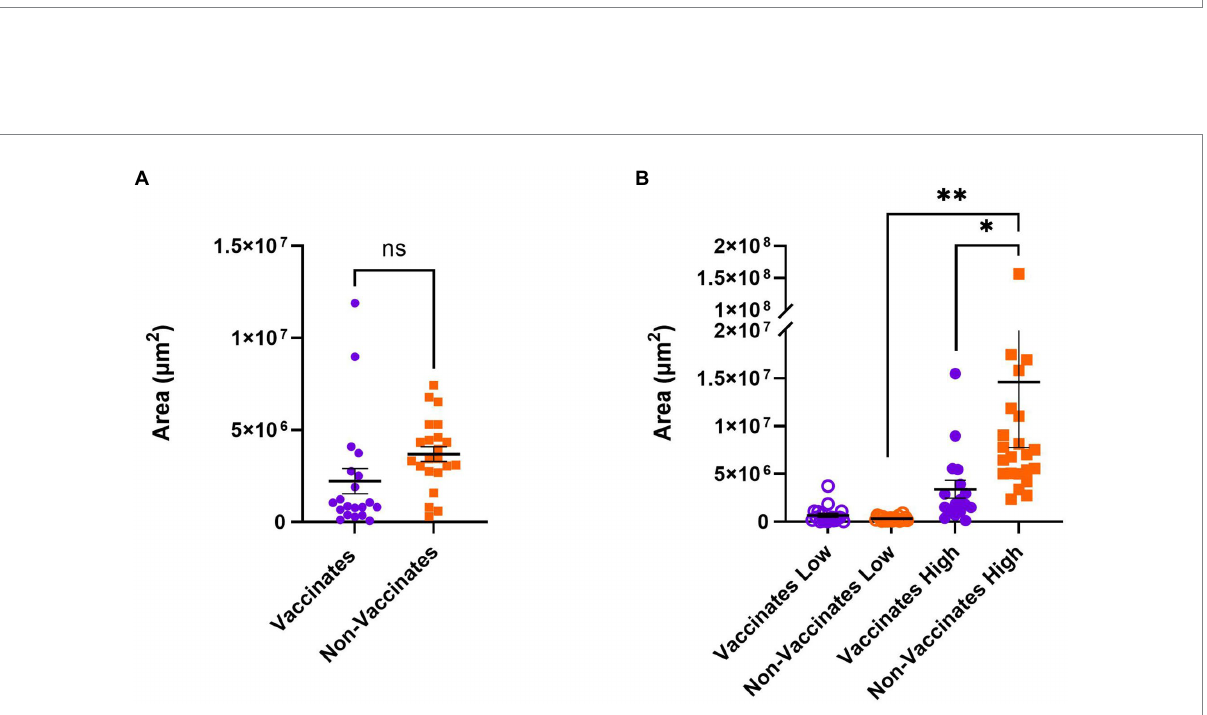
FIGURE 3 Average area of granulomas by both vaccination group and granuloma grade in BCG-vaccinated and non-vaccinated cattle infected with M. bovis . (A) Granuloma size by area ( μ m 2 ) based on vaccination status. Each dot represents one animal. The average area of a granuloma was tabulated by dividing the total area occupied by all granulomas in the mediastinal and tracheobronchial lymph nodes of an animal by the total number of granulomas present. (B) Granuloma size by area ( μ m 2 ) when broken down by grade (high or low). Values are presented as means ± SEM. (* = p value 0.0434, ** = p value 0.0064, ns = not